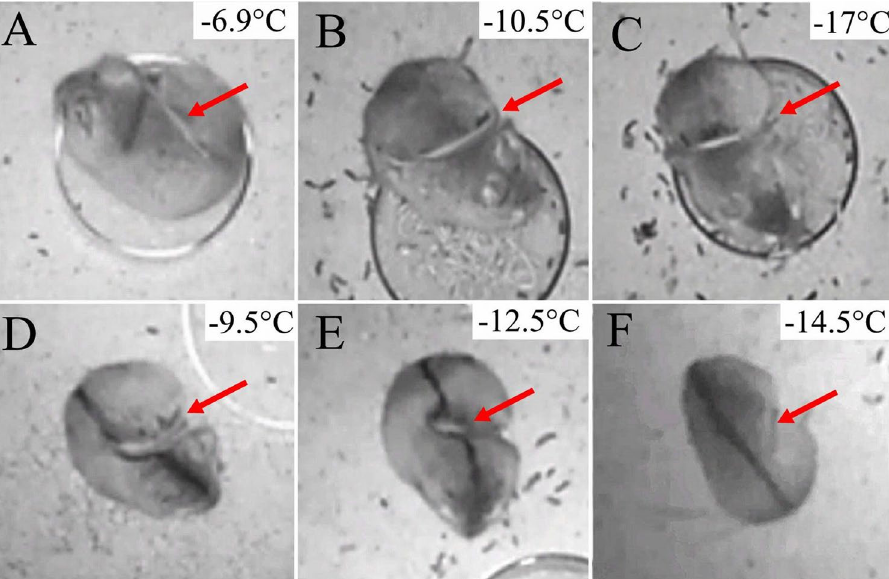
Figure 1. Video stills from IR cameras showing visible tail-belting in mice. ( A – C ) Yellow-necked mice; ( D – F ) Striped field mice. ( A ) and ( D ) show the lowest temperature that tail-belting was recorded at for each of the two species, ( C ) and ( F ) show the highest temperature that tail-belting was recorded at for the two species. Red arrows indicate the position of the tail being